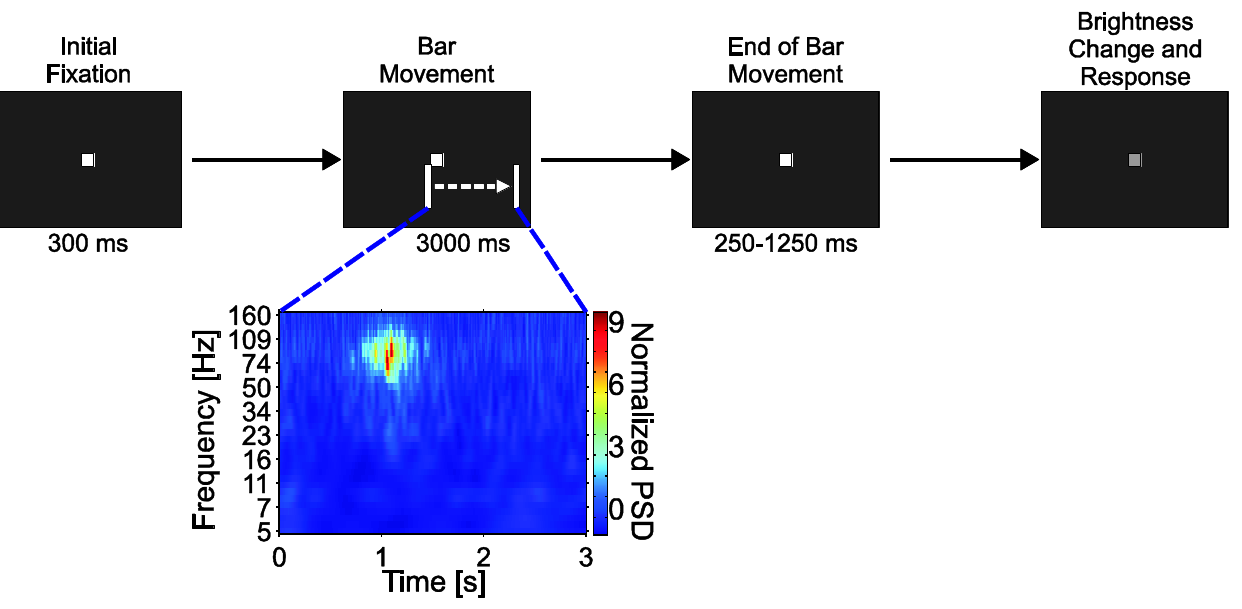
Figure 5. Receptive field mapping task. Movement of the bar stimulus over the receptive field of an electrode is reflected as a temporary increase in ECoG signal